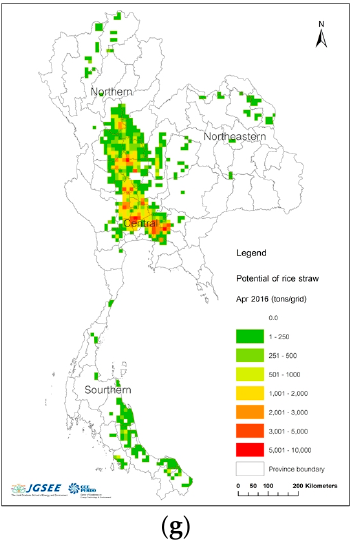
Figure 11. Spatial variation of the net potential of rice straws for each harvesting month: ( a ) October 2015, ( b ) November 2015, ( c ) December 2015, ( d ) January 2016, ( e ) February 2016, ( f ) March 2016, and ( g ) April 2016.